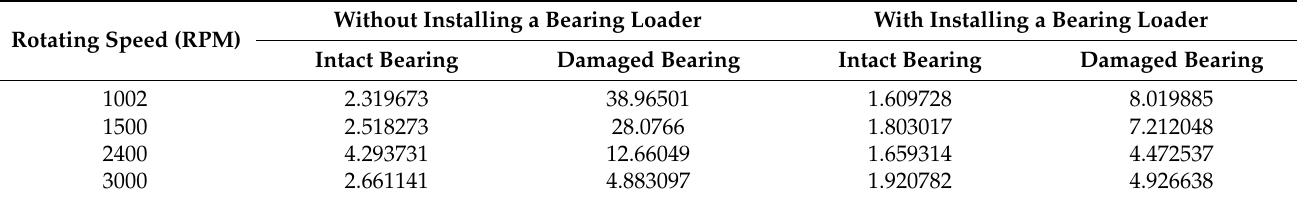
Table 7. Average kurtosis values for a combination